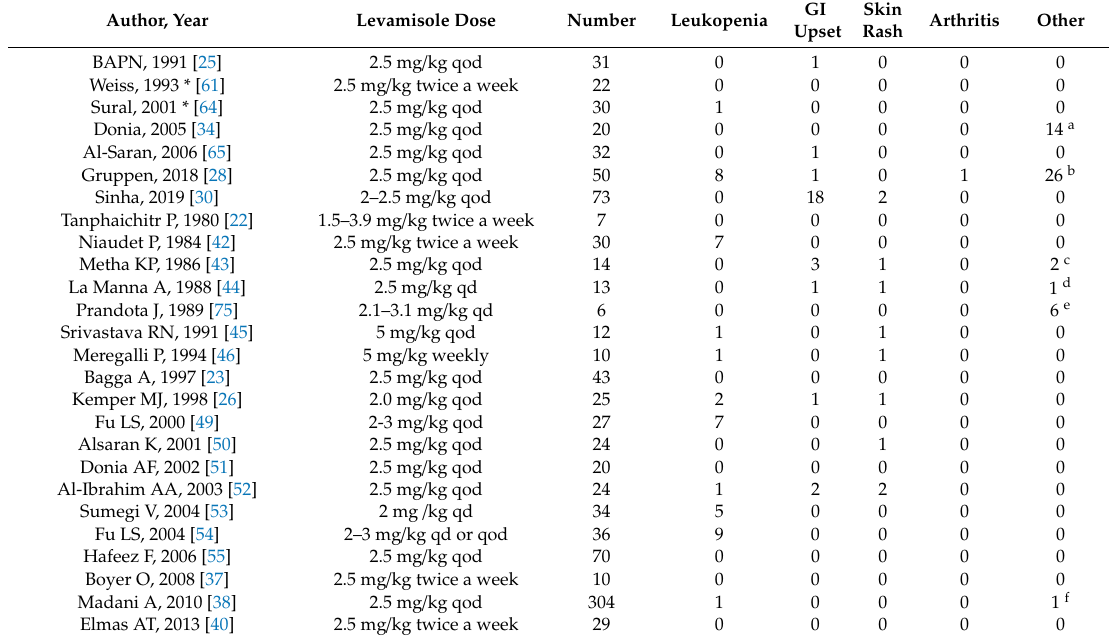
Table 4. Reported side e ff ects of levamisole in nephrotic